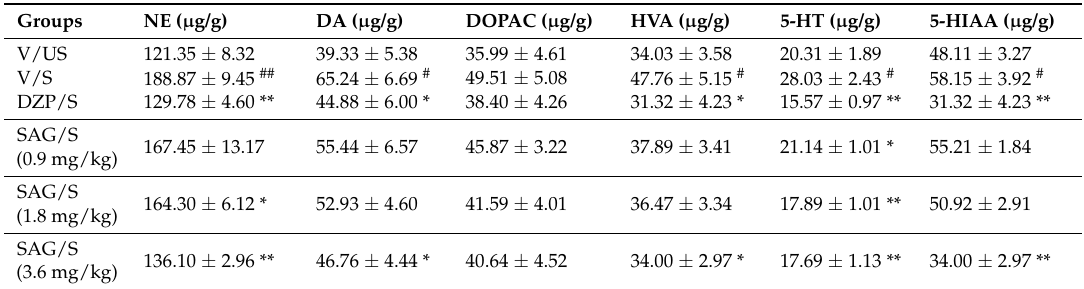
Table 1. Effect of SAG on the monoamines neurotransmitters and their metabolites in the whole cerebral cortex of rats.